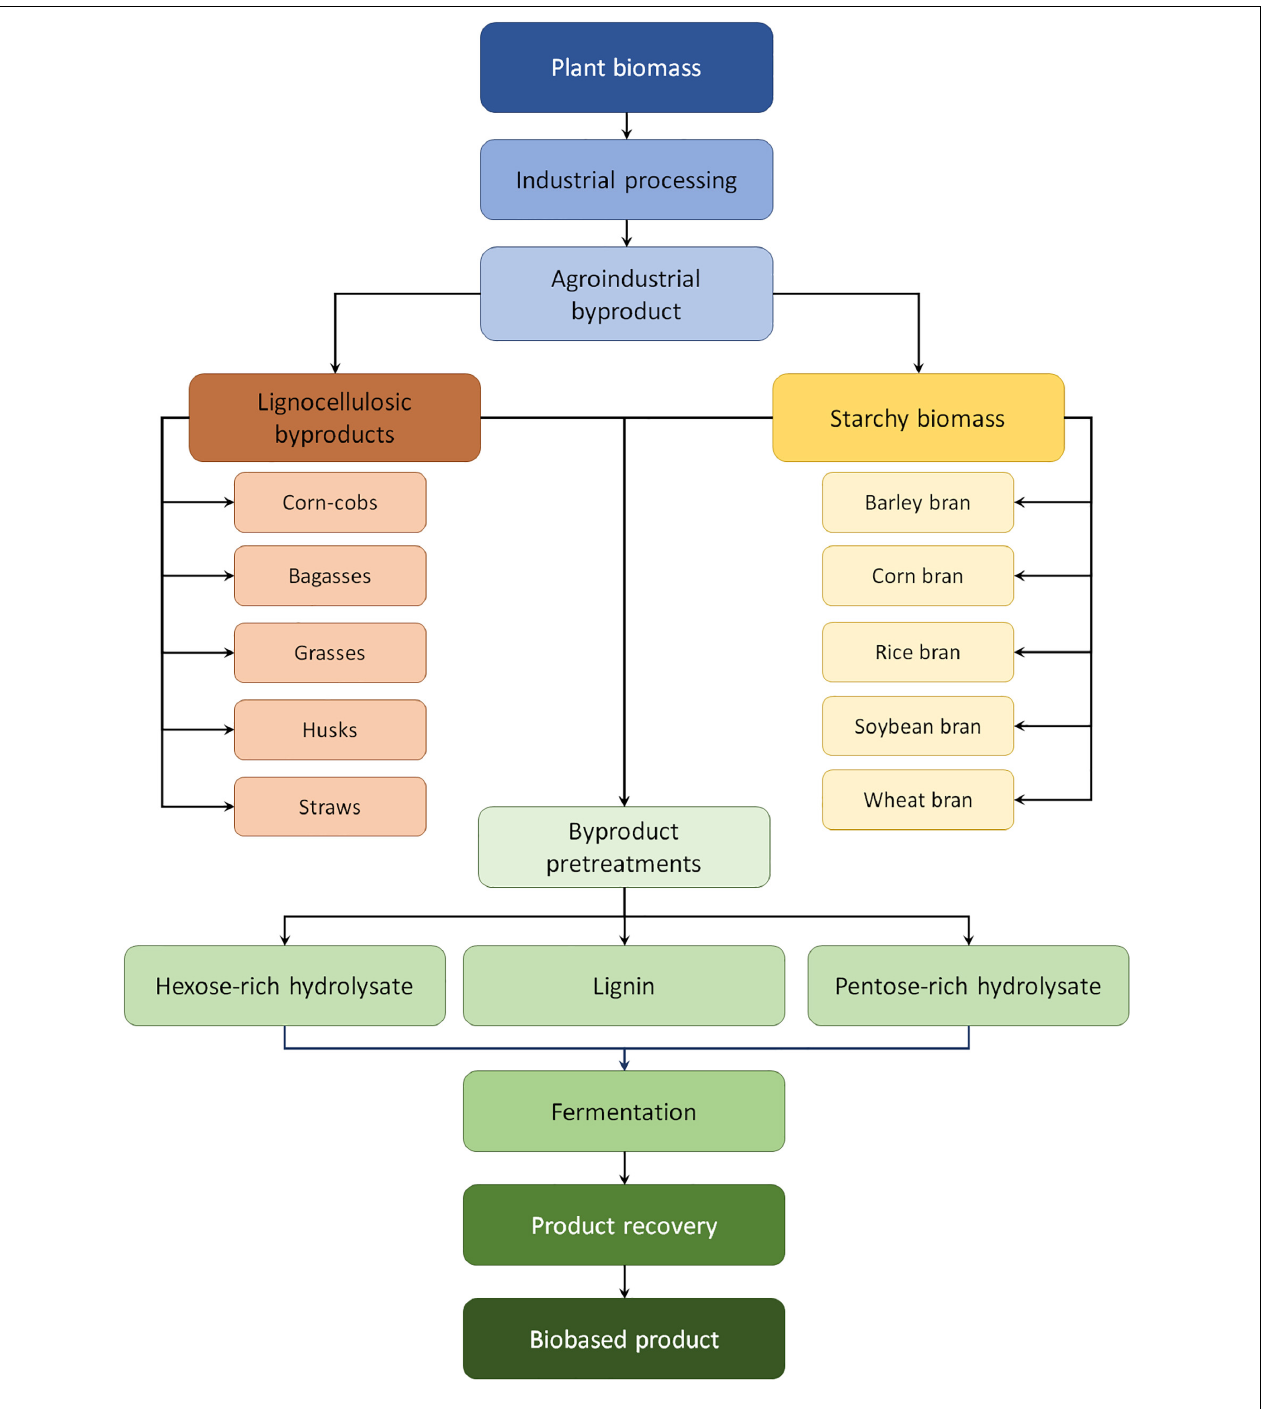
FIGURE 2 | Some feedstocks for the production of